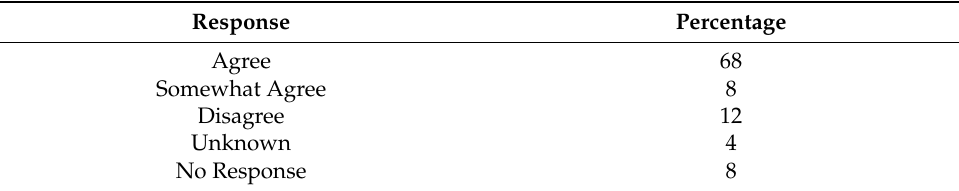
Table 2. Response summary about the characteristics of 70 m buffer